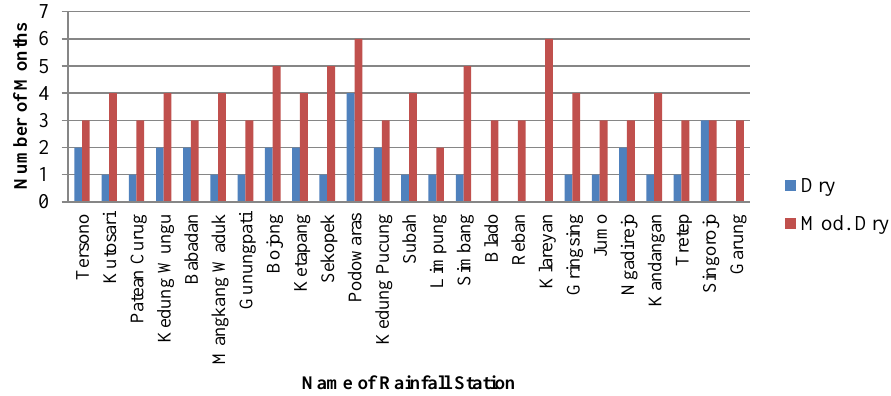
Figure 7. Frequency of rainfall stations experiencing moderately dry or worse conditions in the Bodri-Kuto river